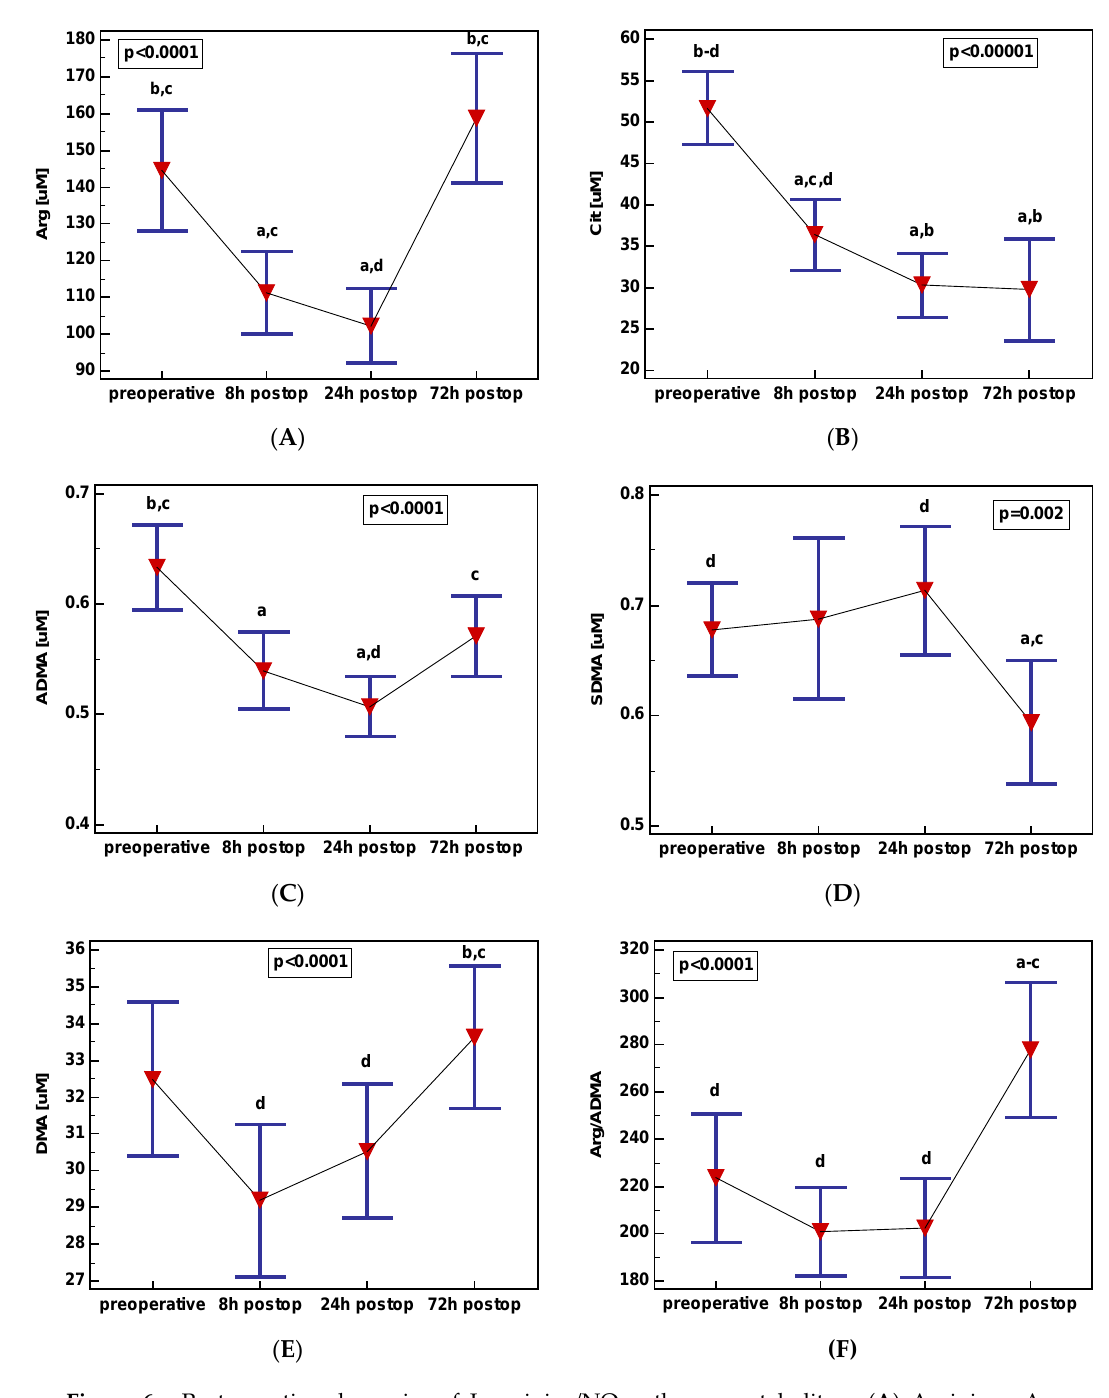
Figure 6. Postoperative dynamics of L-arginine / NO pathway metabolites: ( A )